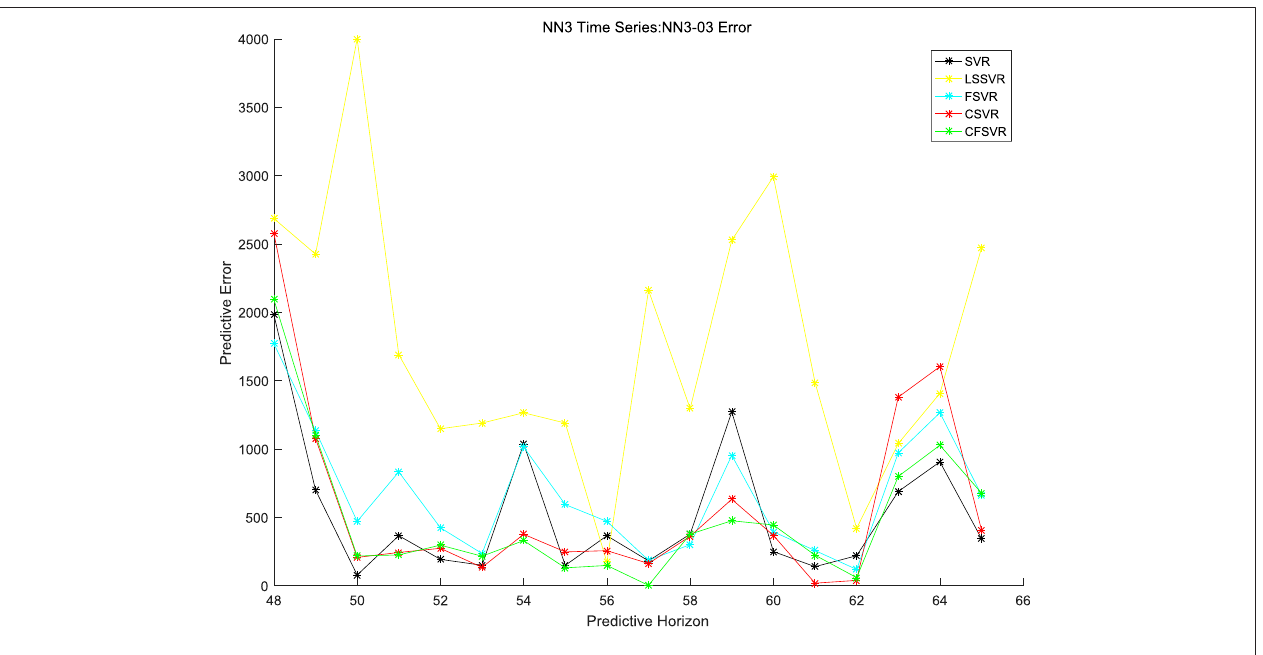
FIGURE 12 | Error of forecasting of NN3 No.